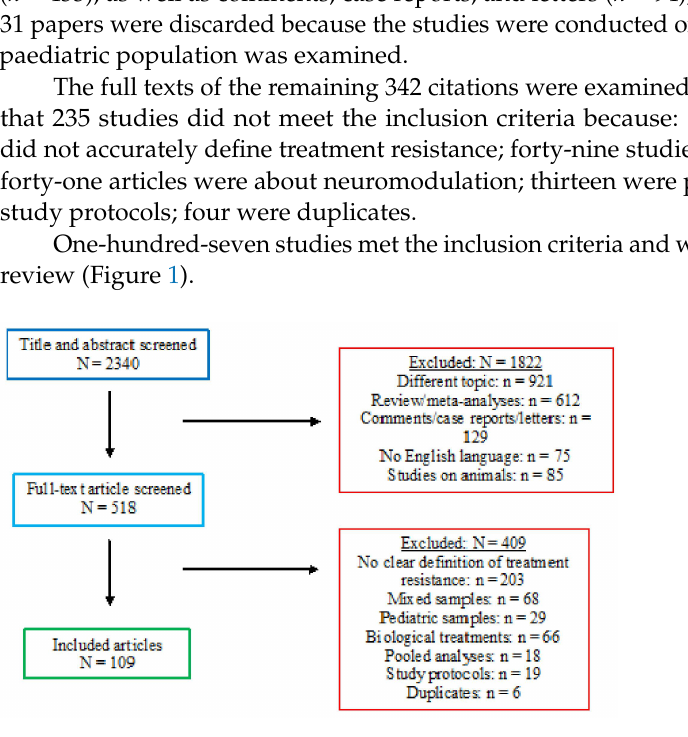
Figure 1. PRISMA flow-chart for systematic